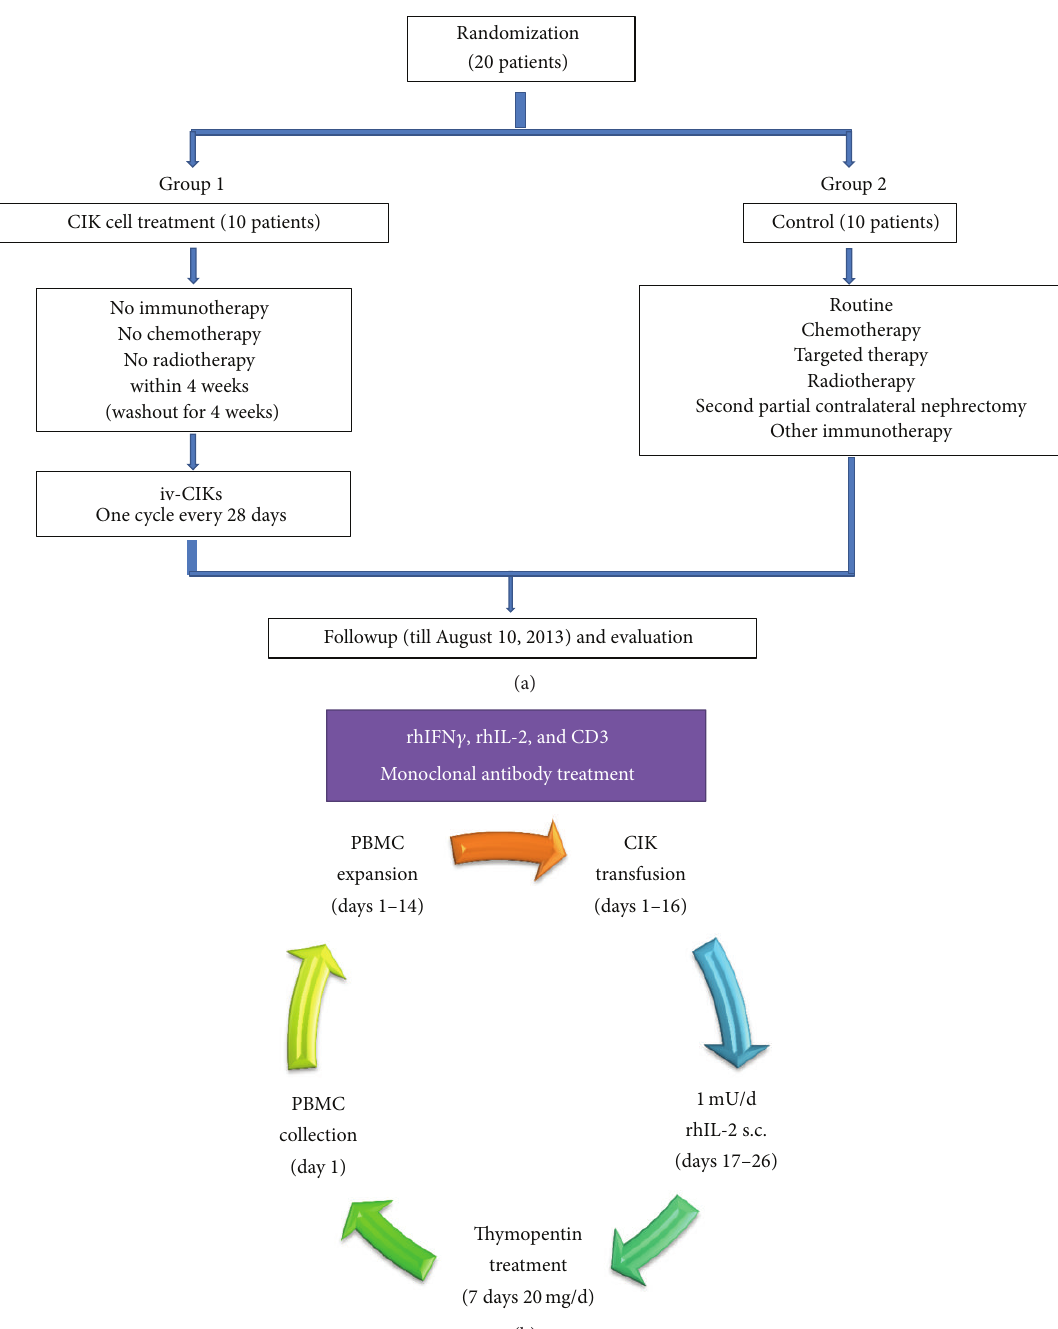
Figure 1: (a) Trials and treatments of the two groups sectionalization. (b) Treatment protocol: cytokine-induced killer (CIK) cell transfusion cycle. Peripheral blood mononuclear cells (PBMCs) were cultured for 14 days in the presence of recombinant human interferon gamma (rhIFN- 𝛾 ), recombinant human interleukin-2 (rhIL-2), and anti-CD3 monoclonal antibody before transfusion for two consecutive days. PatientswereinjectedwithrhIL-2subcutaneouslyat1 mU/dayfor10daysimmediatelyaftertransfusionfor10days.Thymopentinwasinjected intramuscularly for 7 days before the next PBMC collection and